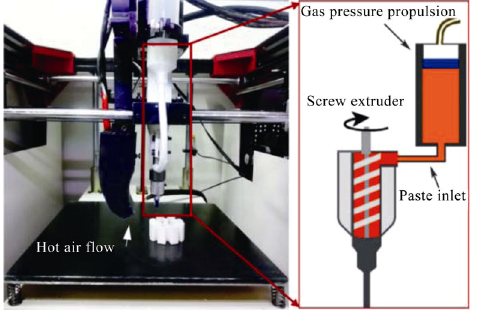
Fig. 1 Schematic diagram of the 3D process for printing alumina ceramics.